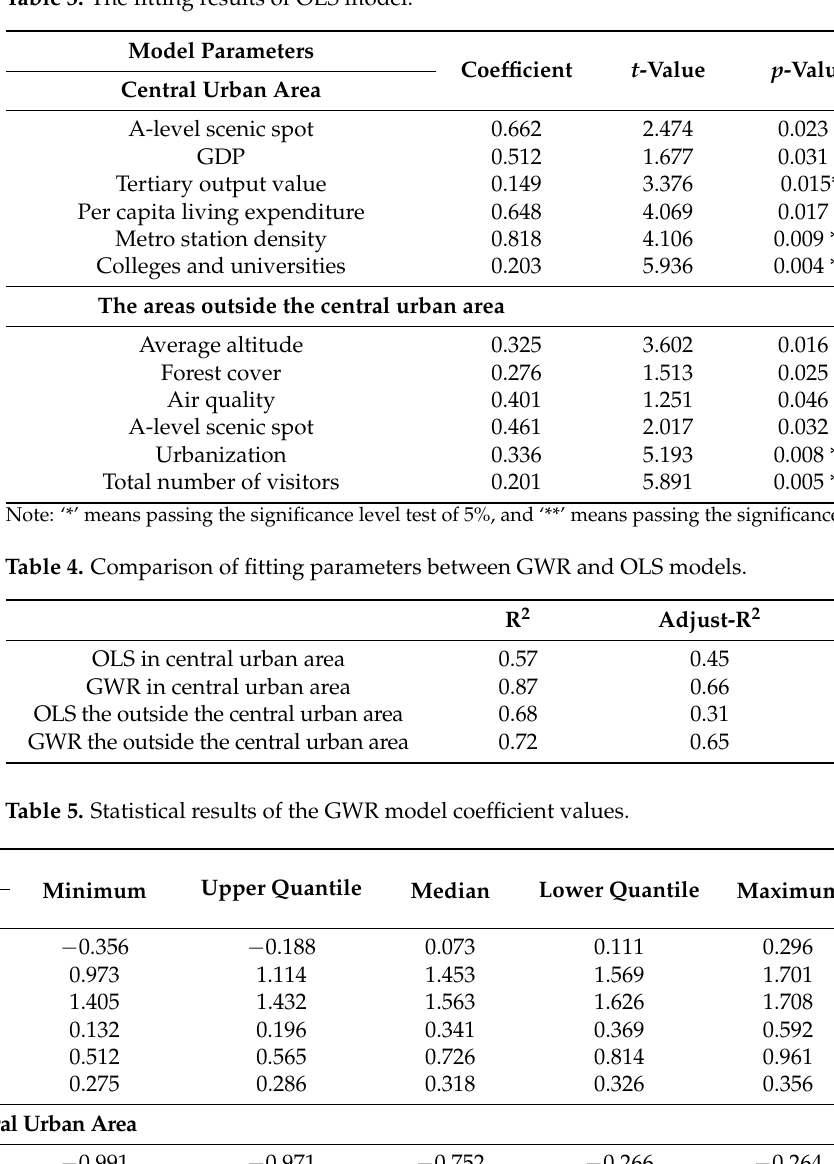
Table 3. The fitting results of OLS model.